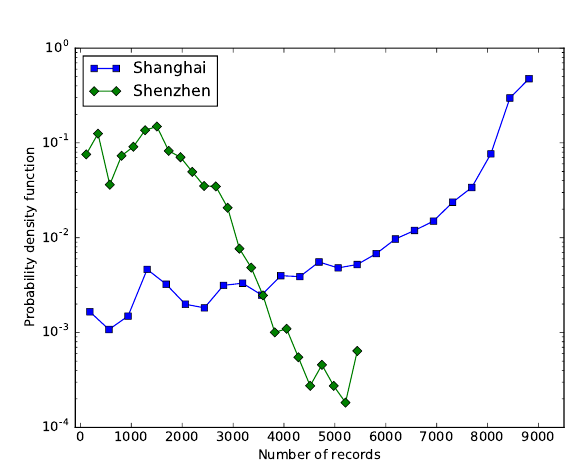
Figure 13. Probability Density Function of the Average Number of a Taxi Trajectory Records Per Day.